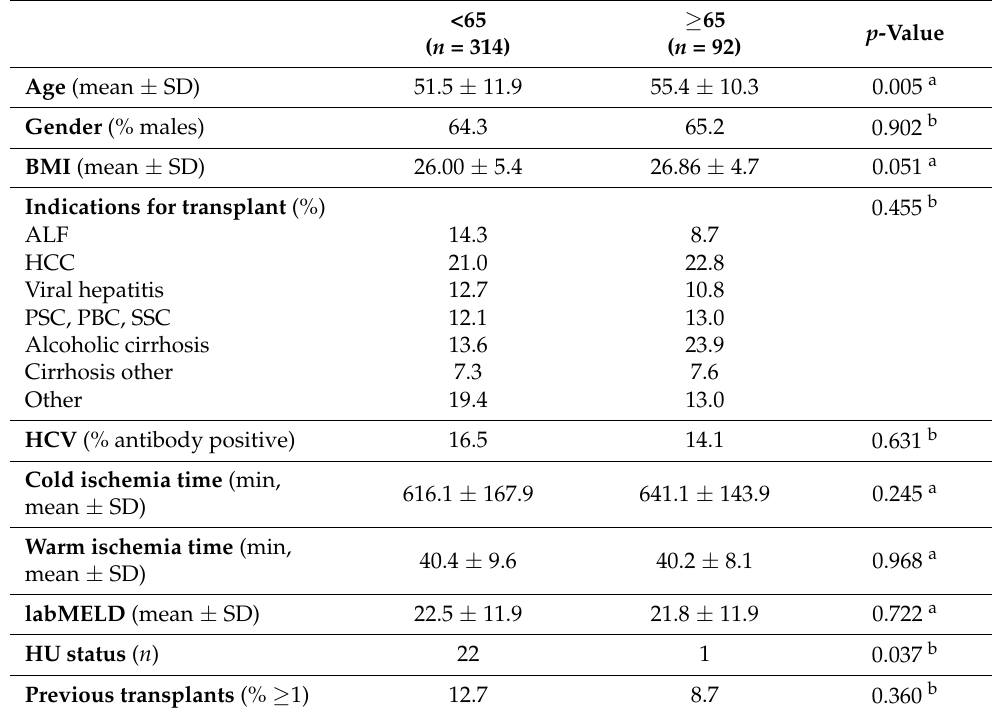
Table 1. Recipient characteristics.